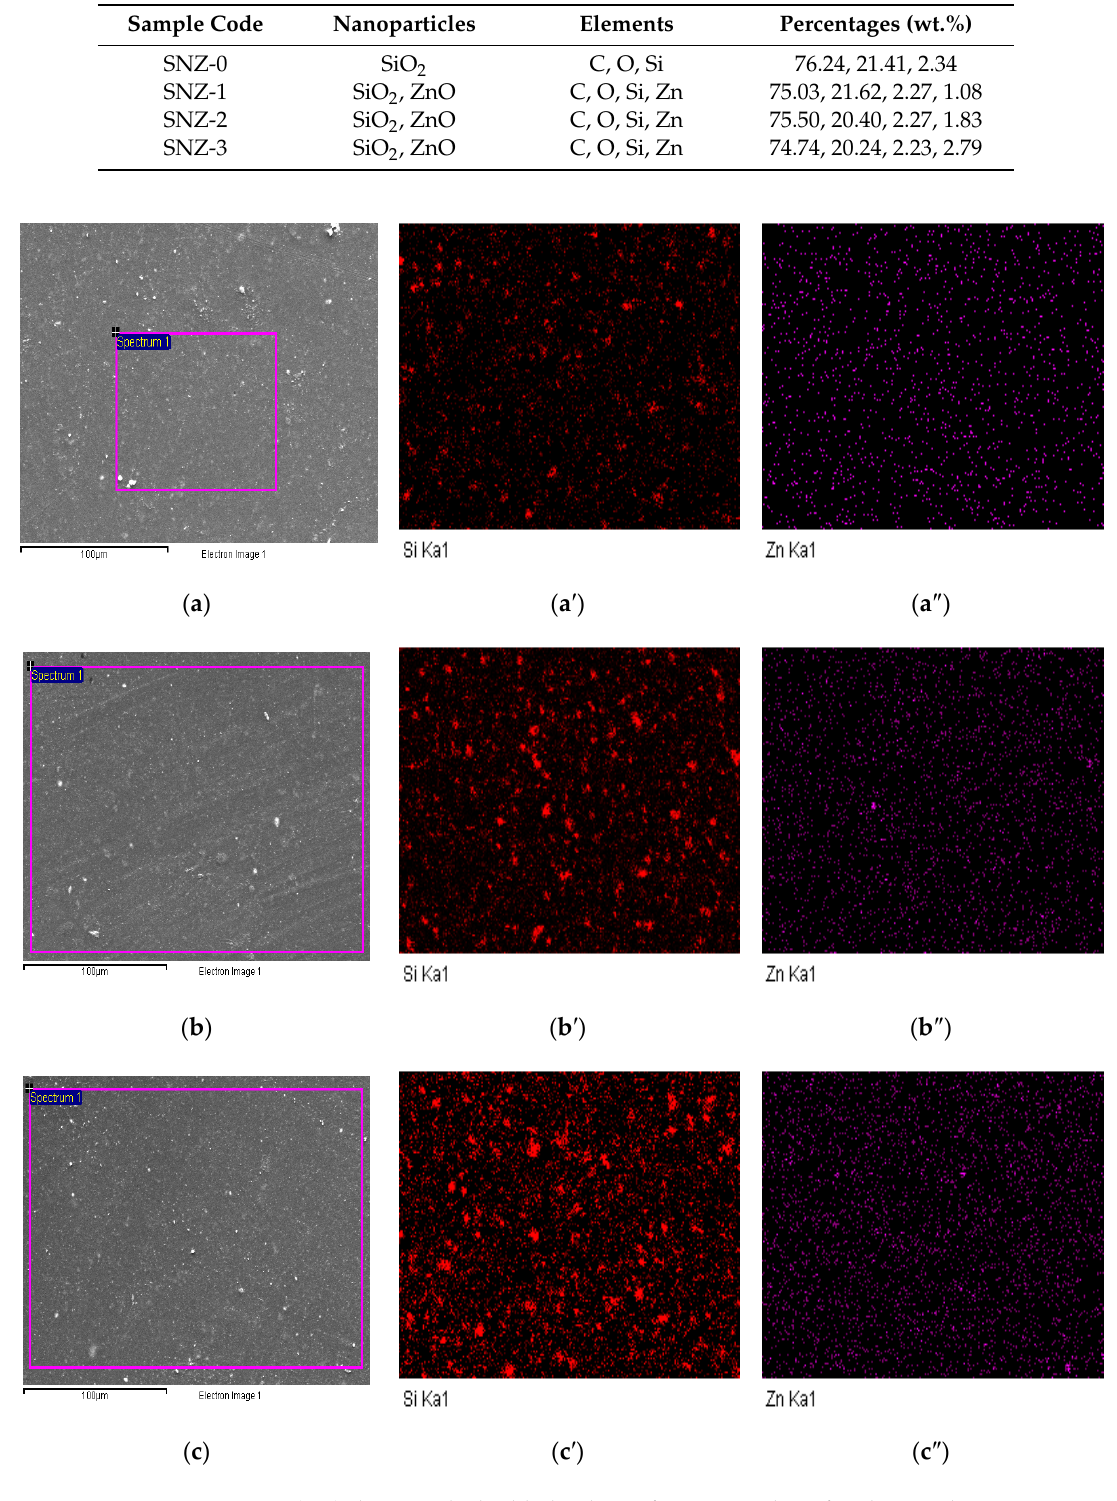
Figure 13. SEM images ( a – c ) showing the highlighted area for EDX analysis for elemental mapping, Si elemental mapping results ( a ′ – c ′ ), and Zn elemental mapping results ( a ″ – c ″ ) for ( a ) SNZ-1, ( b ) SNZ-2, and ( c ) SNZ-3.